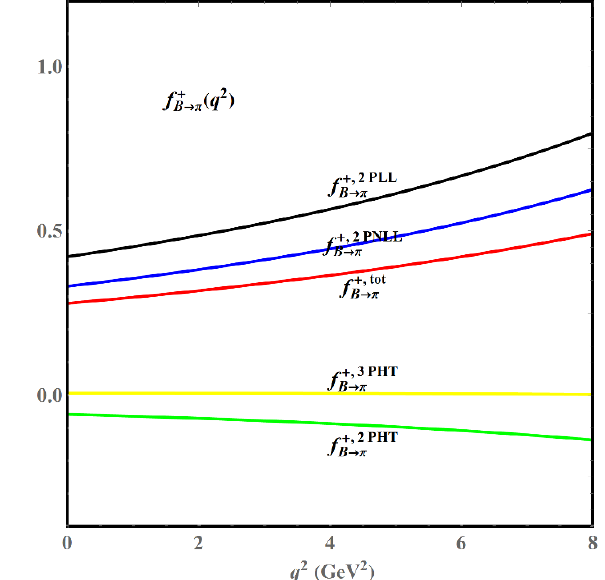
Figure 3 . The momentum-transfer dependence of the vector B ! (cid:25) form factor from the leading- power contribution at LL ( f + ; 2PLL , black), the leading-power contribution at NLL ( f + ; 2PNLL B ! (cid:25) blue), the two-particle higher-twist correction ( f + ; 2PHT , green), and the three-particle higher-twist B ! (cid:25) correction ( f + ; 3PHT , B ! (cid:25)